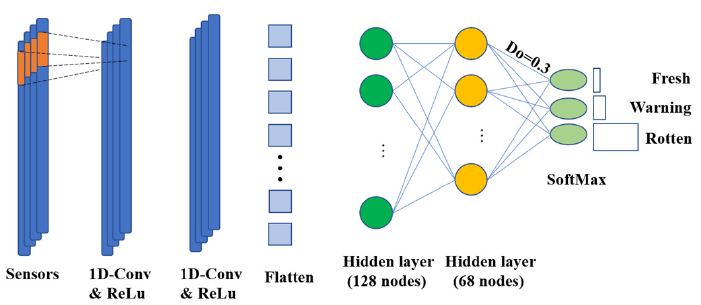
Figure 18. Structure of the 1D-CNN model.